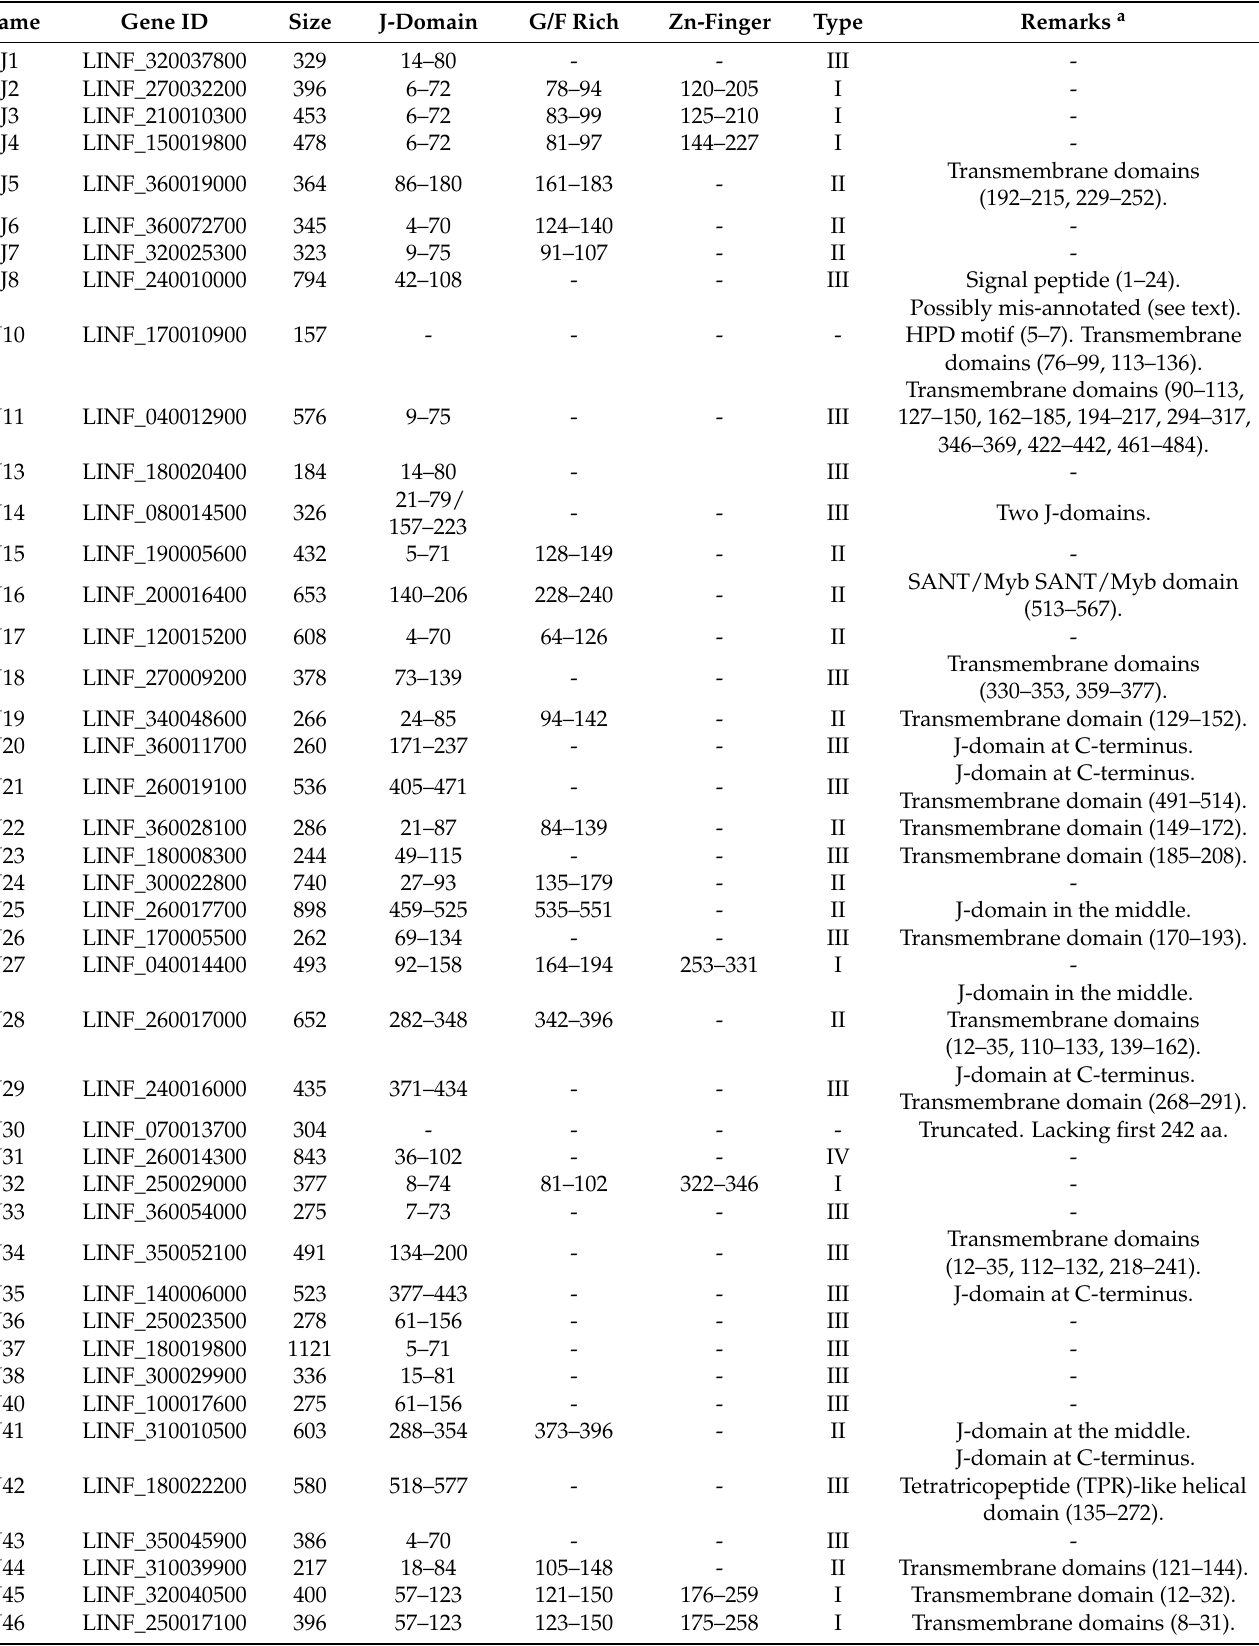
Table 1. L. infantum HSP40